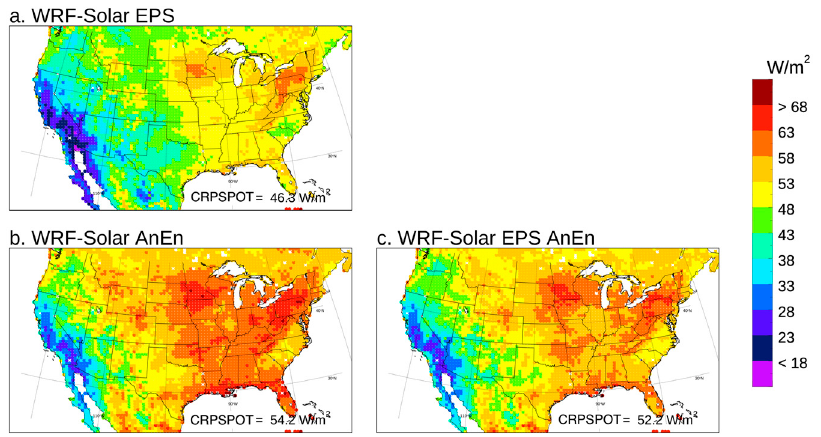
Figure 8. Continuous ranked probability score (CRPS) map computed for GHI pooling runs and the forecast lead times from +24 to +48 h for 2018 together.